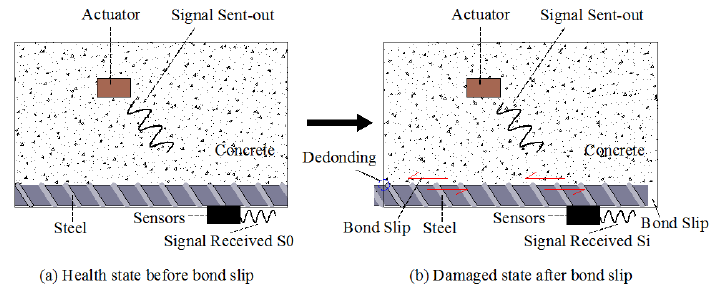
Figure 8. Smart aggregate-based active sensing approach to detect bond slip between the steel plate and concrete [104].